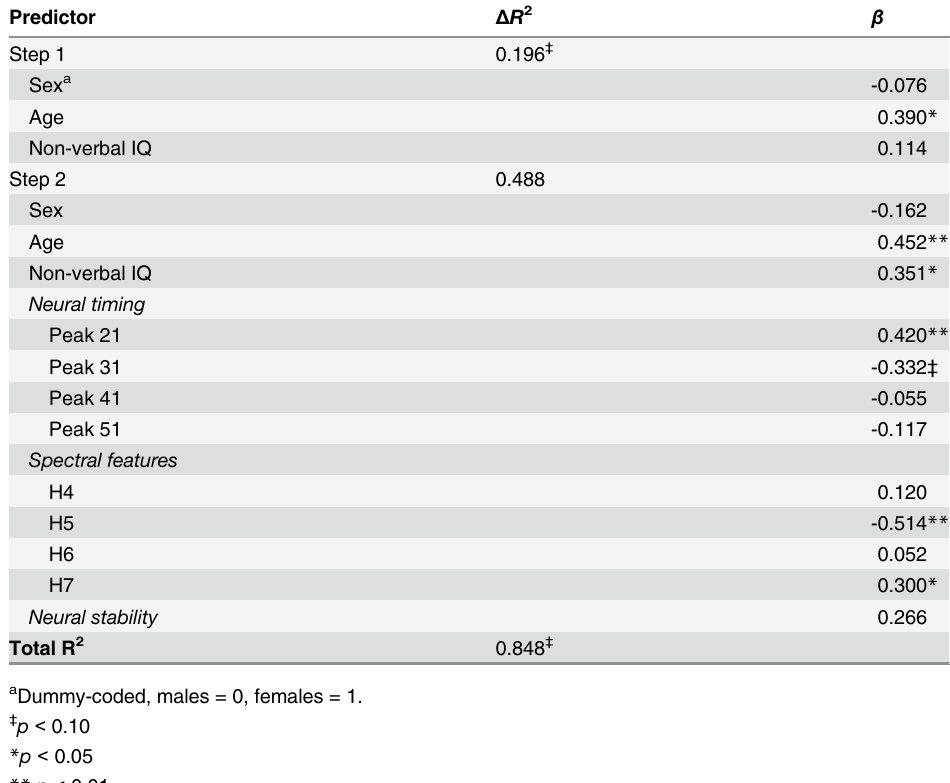
Table 1. Neural coding of consonants in noise predicts preschooler ’ s phonological processing. These model parameters are applied in Experiments 2 – 4. Predictor Δ R 2 β Step 1 0.196